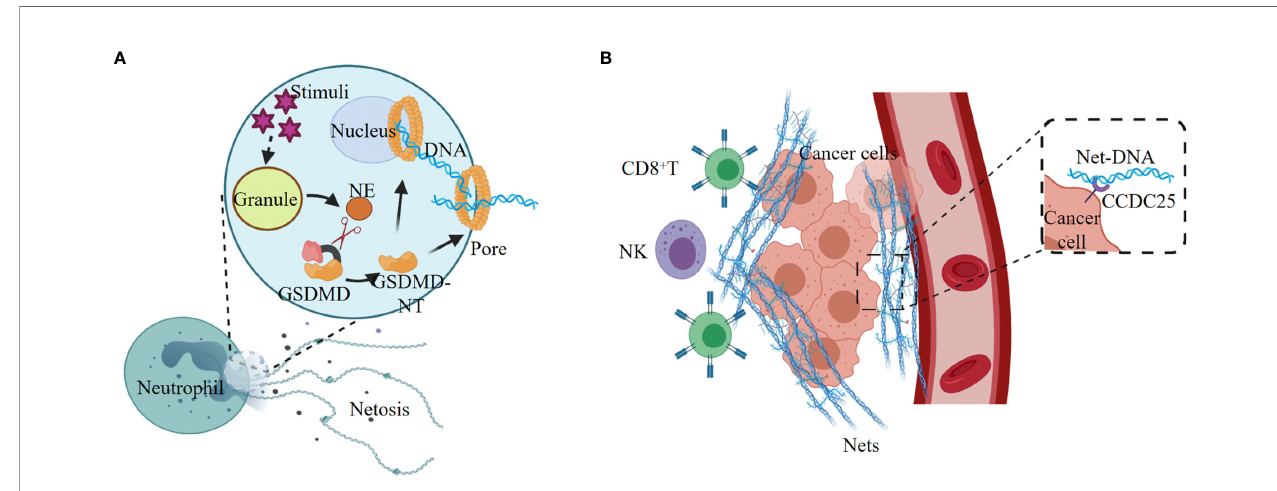
FIGURE 3 | NETosis elicited by noncanonical in fl ammasome signaling promotes tumorigenesis. (A) Various stimuli promote the release of NE from the granules, and NE cleaves and activates GSDMD, leading to nuclear and plasma membrane rupture and neutrophil cell lysis by NETosis. (B) Tumor-secreted ligands induce extrusion of NETs, and NETs protect tumor cells from CTL and NK cytotoxicity. The extracellular NETs-DNA binds to the transmembrane protein CCDC25 on tumor cells, and thus improve tumor cell